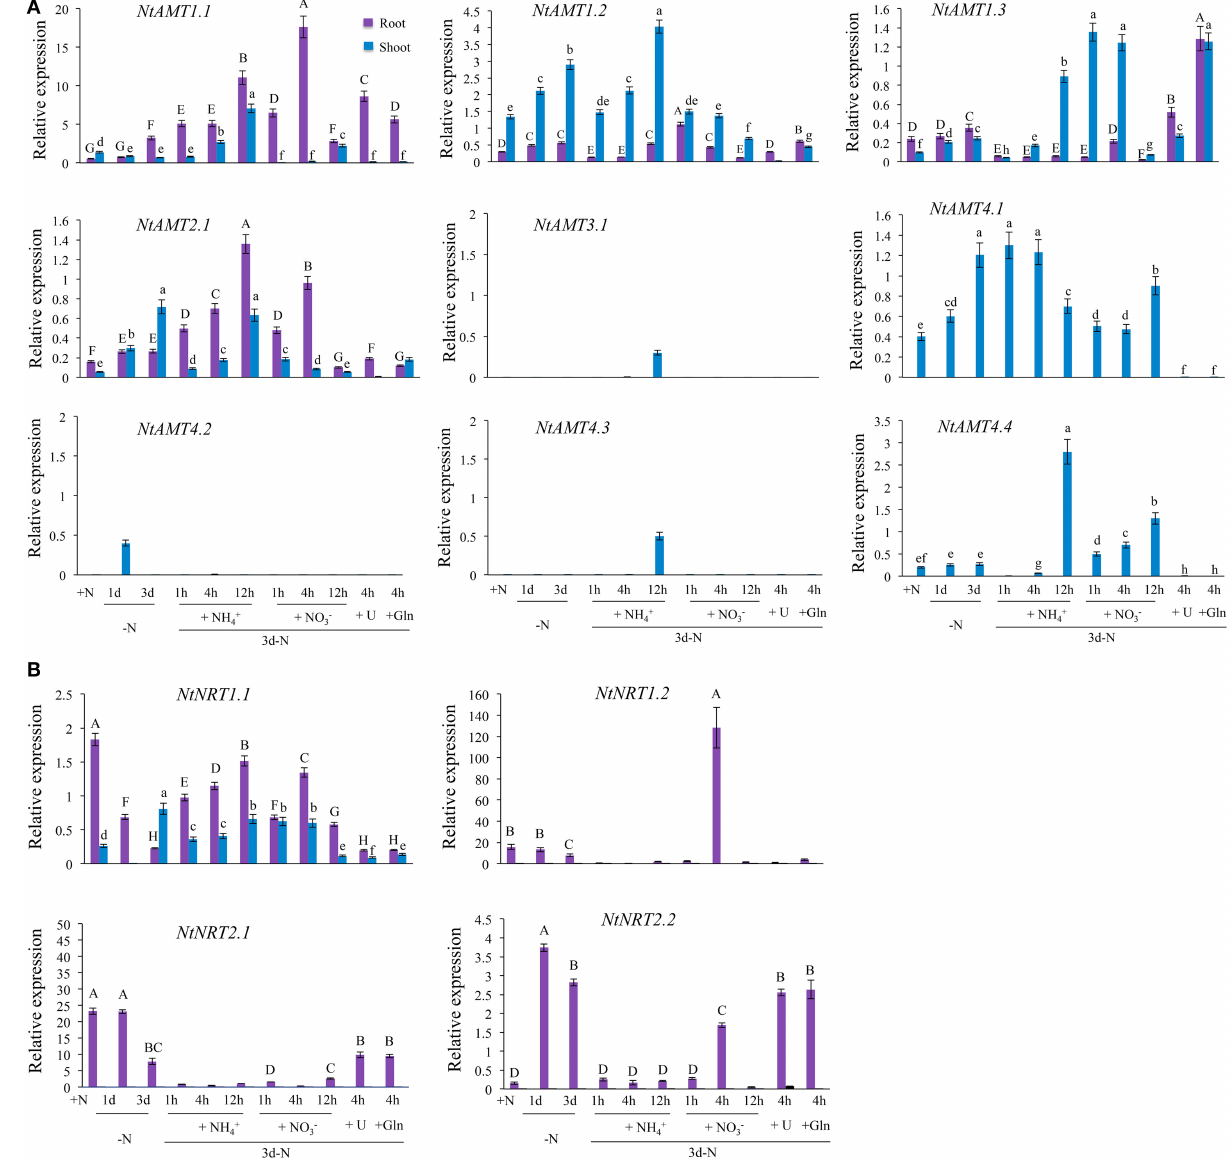
Frontiers in Plant Science |